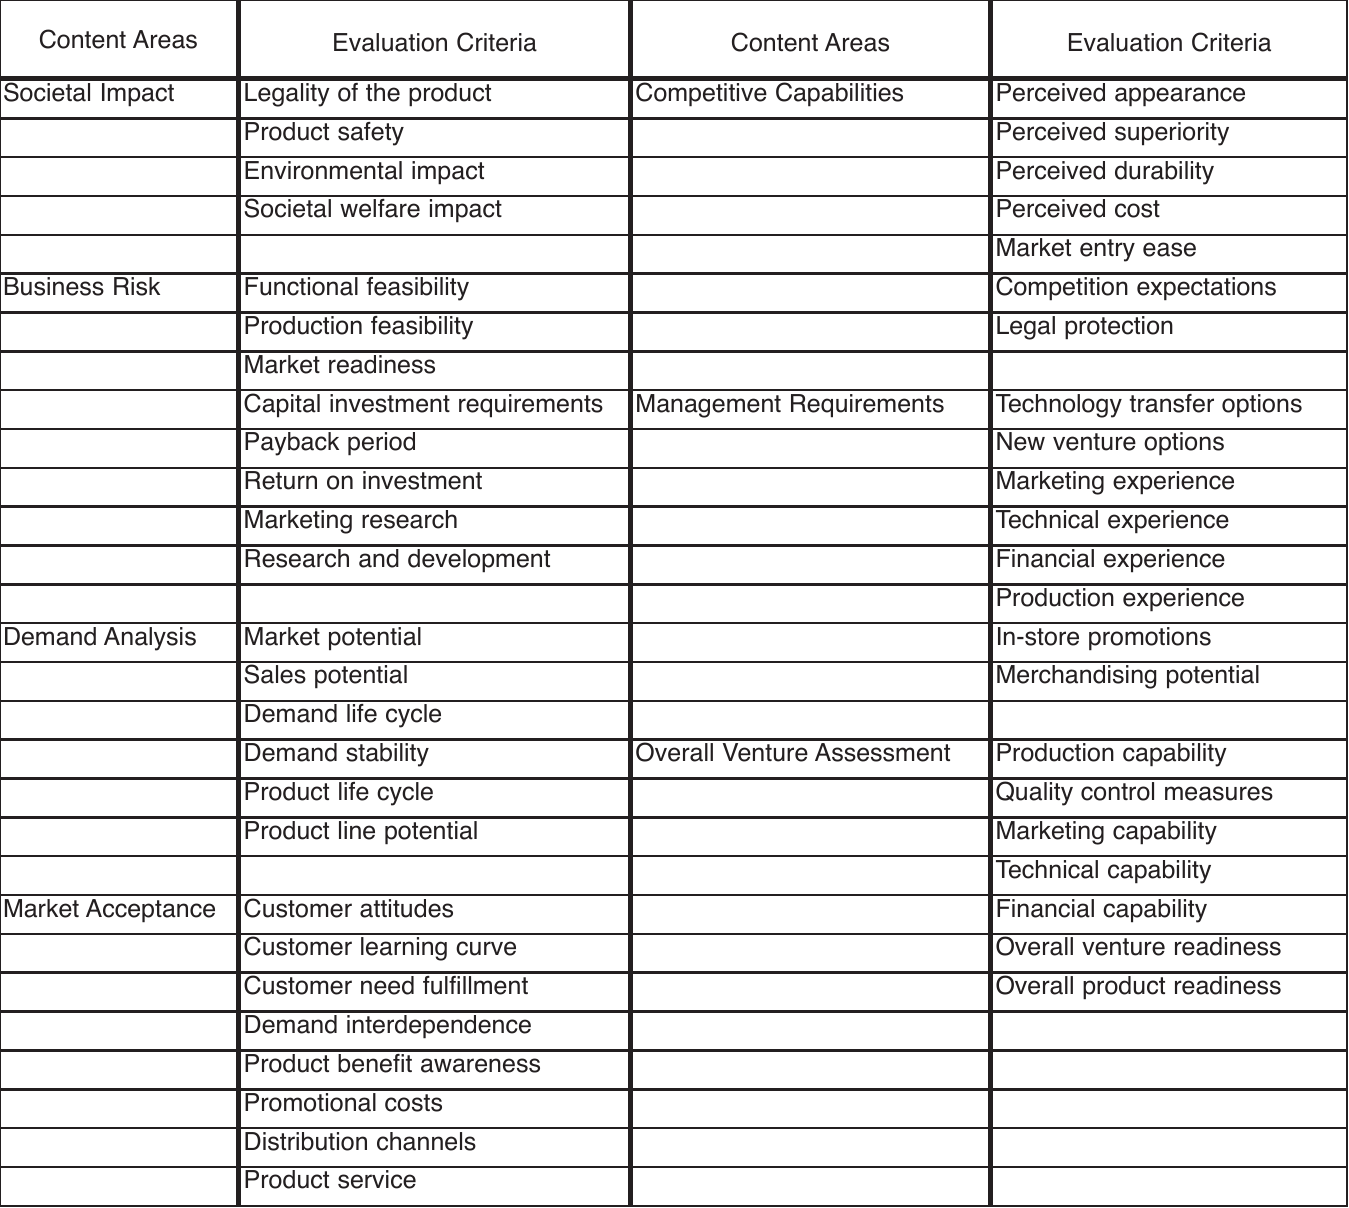
Figure 2. Product Evaluation Criteria Used in This